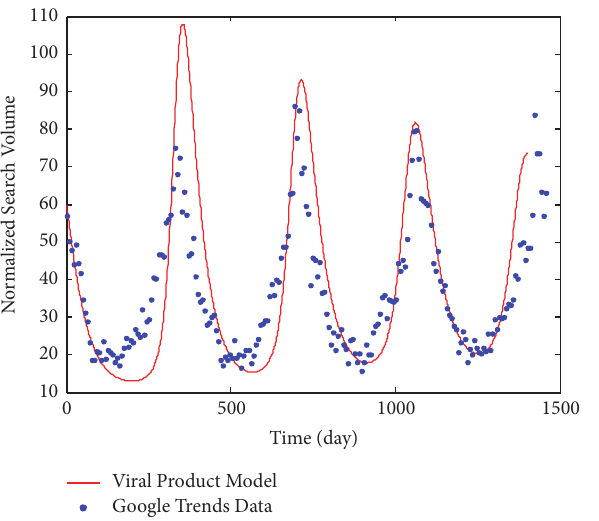
Figure 4: Model fitting on “The North Face” from January 2012 to January 2016.